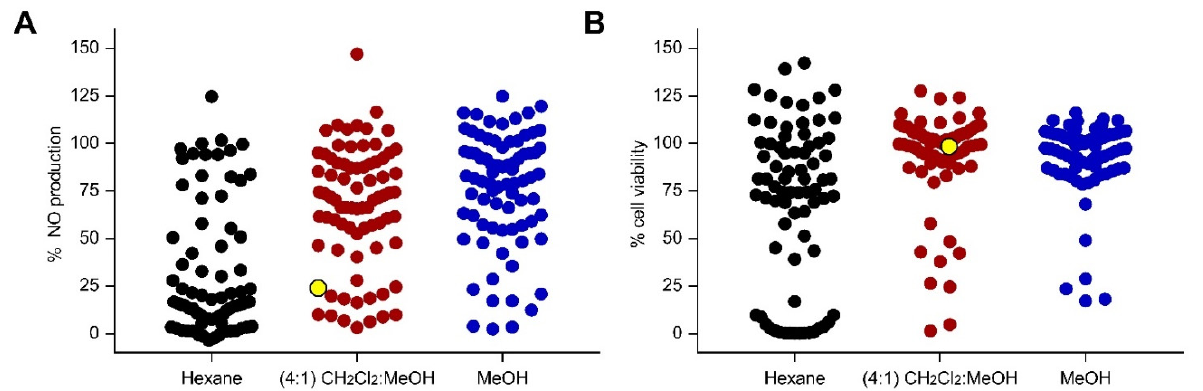
Figure 1. Screening for anti-inflammatory activity of 231 marine sponge crude extracts based on ( A ) NO production and ( B ) cell viability counter-screen at 50 μ g/mL in LPS-stimulated RAW 264.7 cells. Each dot represents the % NO production ( A ) or % cell viability ( B ) of LPS-stimulated RAW 264.7 cells in response to the extract treatment. Lipophilic extracts are shown in black, while semipolar and polar extracts are displayed in maroon and blue, respectively. The CH 2 Cl 2 :MeOH (4:1) extract of N. compacta Lala1F sponge, highlighted in yellow, reduced the NO production by 76% at 50 μ g/mL, with no observable cytotoxic effects. The positive controls, dexamethasone (50 μ M) and t BHQ (10 µ M), reduced NO production by 50% and 90%, respectively, with no observed cytotoxicity. Data are presented as the mean of % NO production or % cell viability ( n = 3).